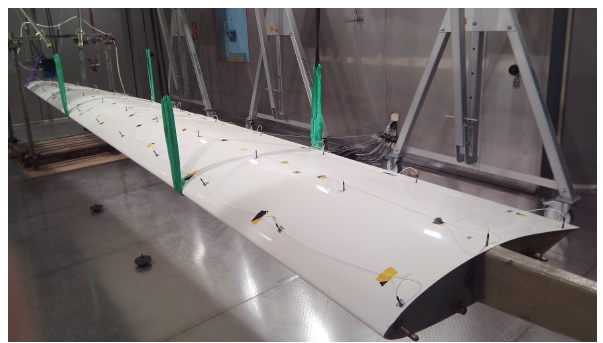
Figure 2. Photograph of the experiment setting in the testing cham- ber.